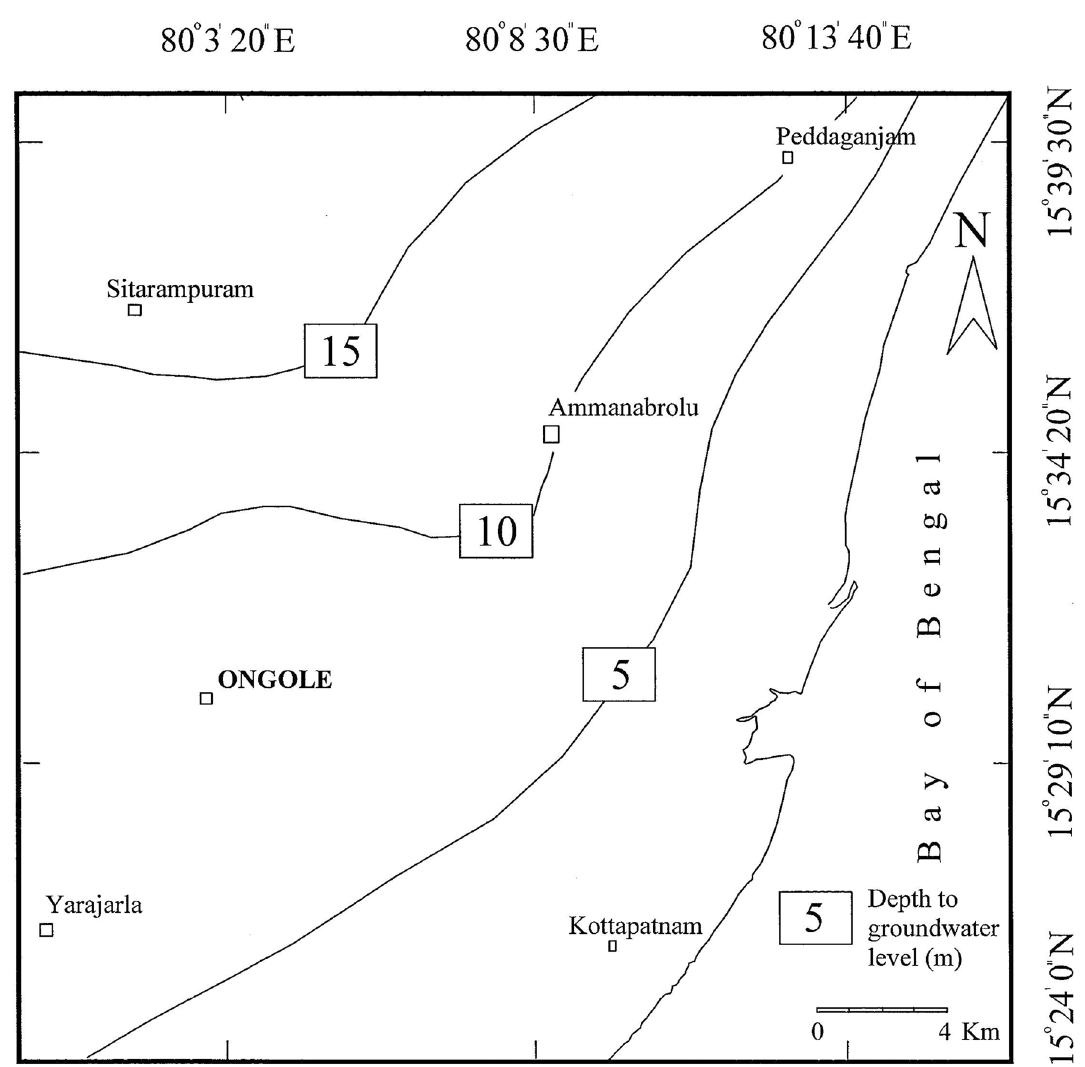
Fig. 3 Depth to groundwater